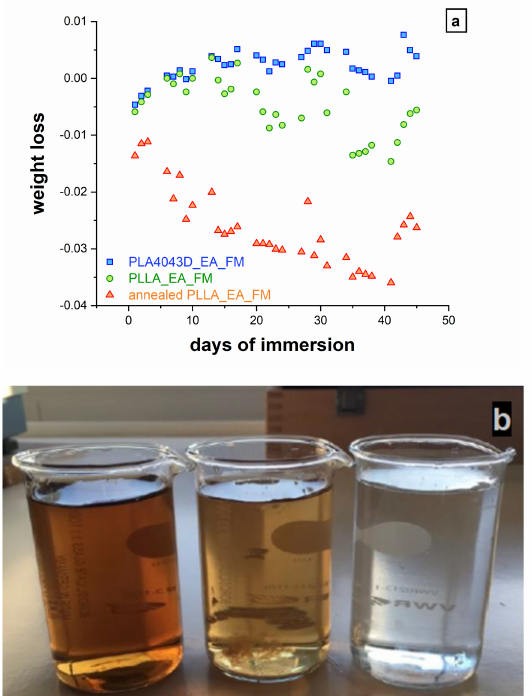
Figure 4. ( a ) evolution of the composite mass with the time of immersion, ( b ) solutions taken from the immersion medium. From left to right: annealed PLLA_EA_FM, PLLA_EA_FM,